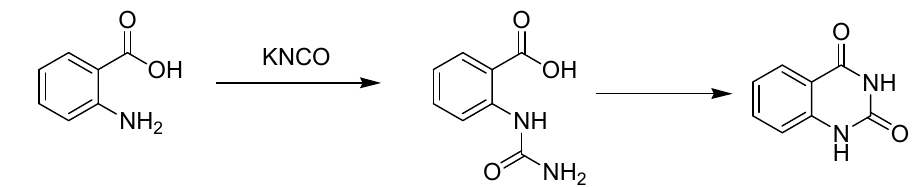
using Di-tertiary-butyl peroxide (DTBP) and p-Toluene sulfonic acid (p-TsOH) to get